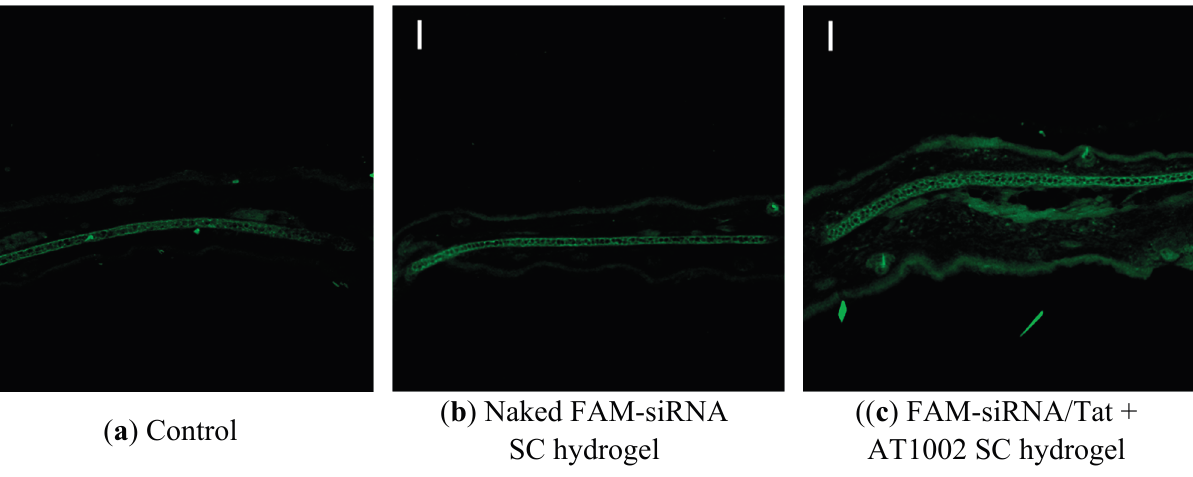
Figure 2. Intradermal distribution of FAM-siRNA in AD-like ear of model mice. ( a ) Control; ( b ) Naked FAMsiRNA SC hydrogel; or ( c ) FAM-siRNA/Tat+AT1002 SC hydrogel was applied to the left ear skin of AD model mice after 10 h. Control refers to non- applied mice. The ear-skin sections (20 μ m) were observed by confocal laser microscopy. Bar: 100 μ